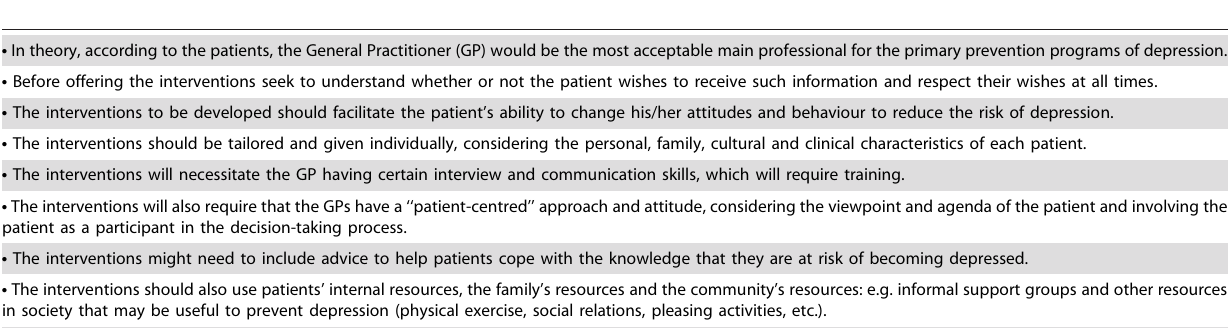
Table 3. Practical implications to bear in mind when designing a primary prevention programme for depression based on the patients’ understanding of their level and profile of